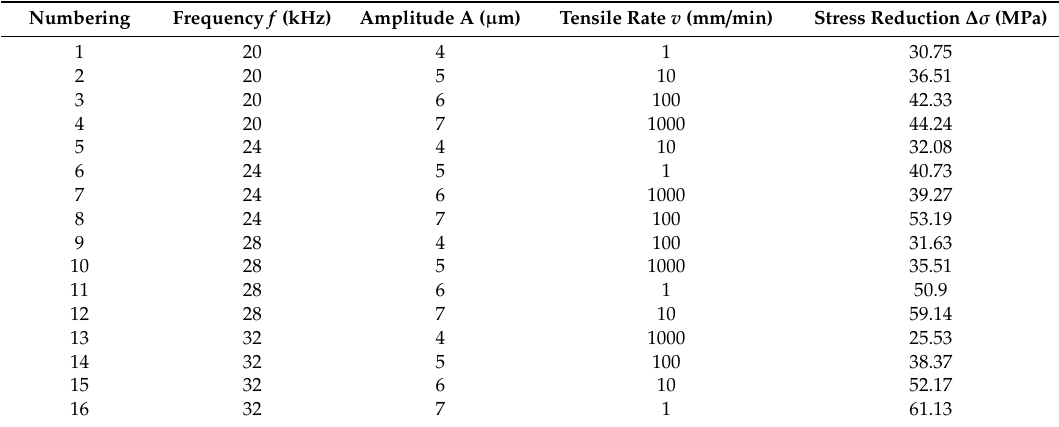
Table 9. The orthogonal simulation results of the stress reduction amplitude.